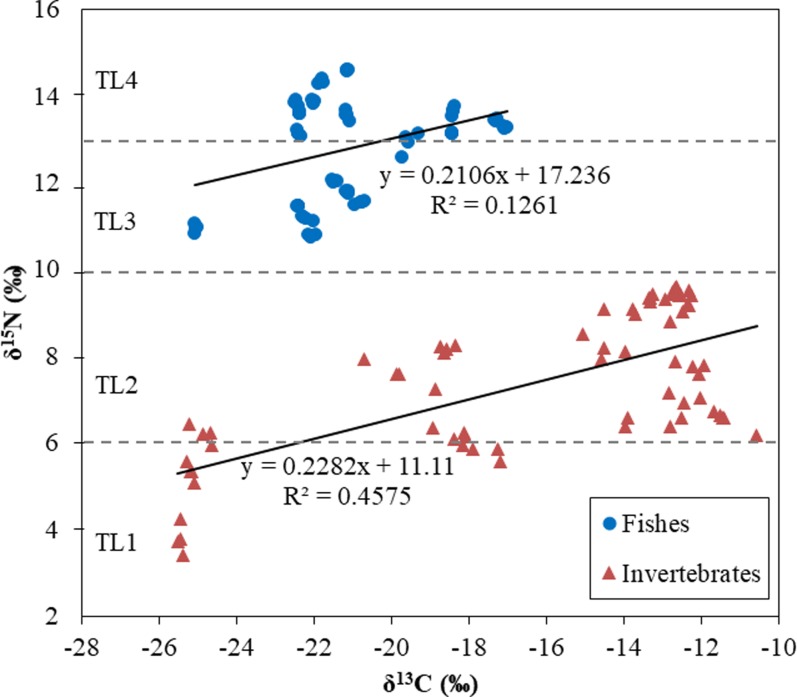
Range of stable isotope ratios of carbon (δ13C) and nitrogen (δ15N) in the Antarctic notothenioid fish and invertebrates.